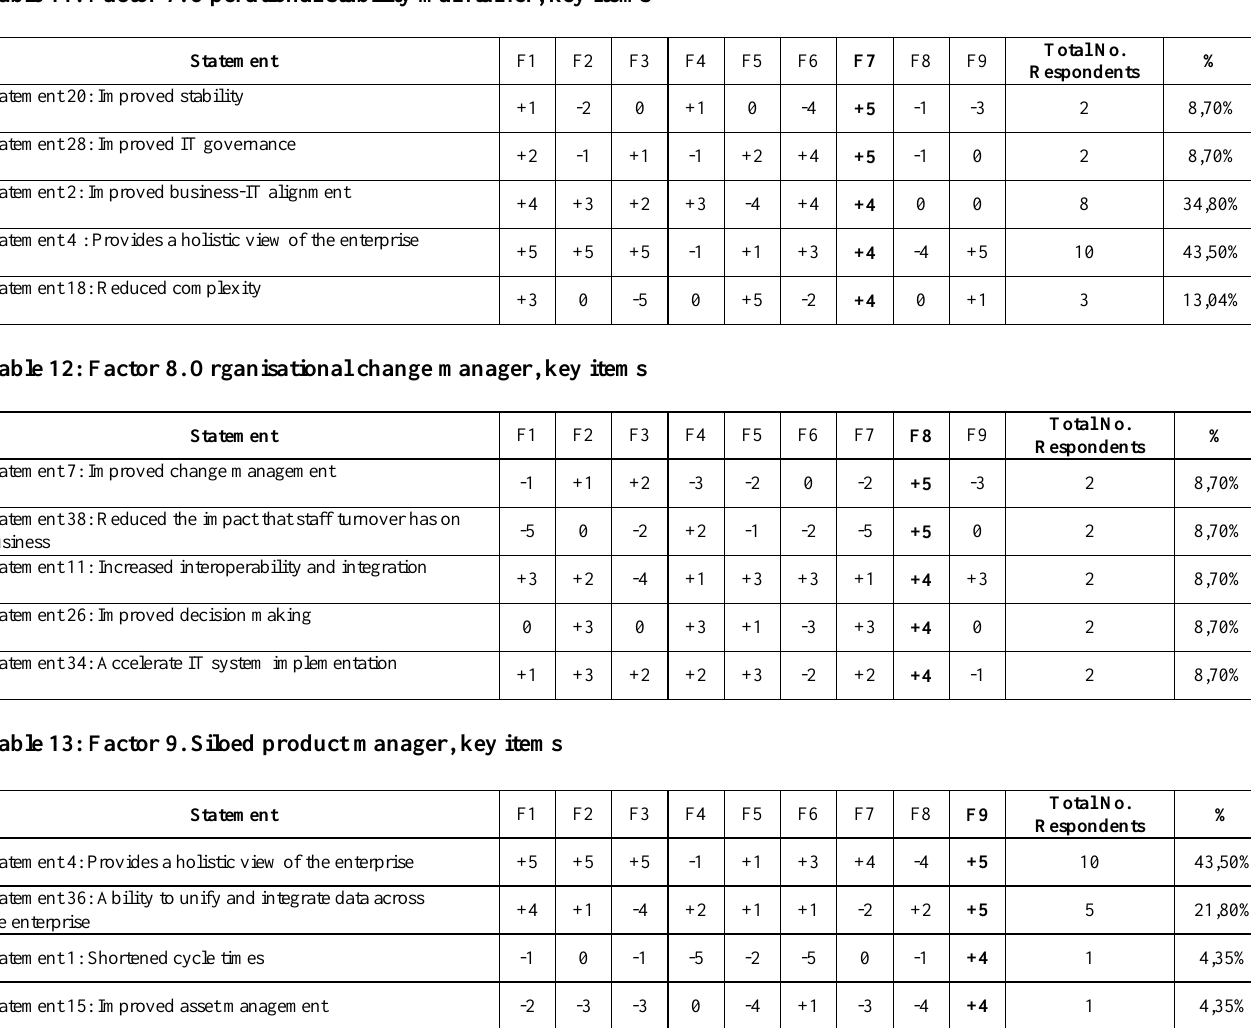
Table 11: Factor 7. Operational stability maintainer, key items